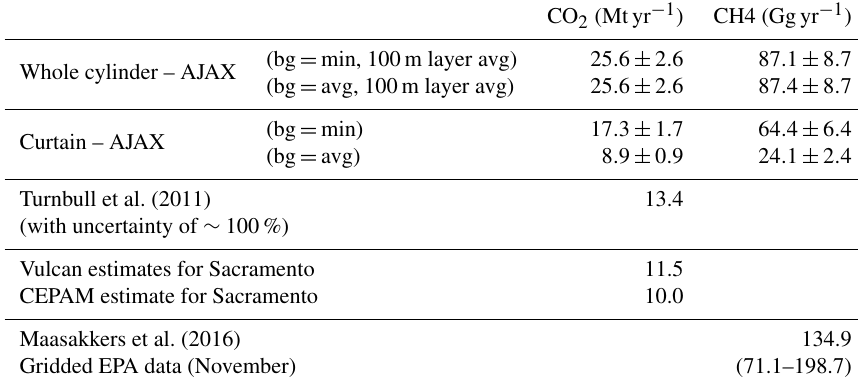
Table 3. Flux estimates for the Sacramento urban area from measurements made on 18 November 2013. The two “curtain” calculations used the same wind treatments as the “whole cylinder” calculations (mass-balanced wind). Turnbull et al. (2011) data were collected in 2009; the value given here was converted from the mean reported value of 3.5MtCyr − 1 with a 1.1%yr − 1 increase in CO 2 flux to adjust to 2013. Bottom-up inventory estimates of the annual total emissions from Sacramento County from Vulcan (Gurney et al., 2009) and the California Air Resources Board CEPAM database (Turnbull et al., 2011) are included for comparison for CO 2 . The Vulcan inventory is available only for 2002, and the CEPAM database is available for 2004. We applied a 1.1%yr − 1 increase in CO 2 flux to adjust to 2013. The gridded (0.1 ◦ × 0.1 ◦ ) National U.S. Environmental Protection Agency (EPA) Inventory for November 2012 is included for comparison for CH 4 . We applied a 0.6%yr − 1 increase in CH 4 flux to adjust to